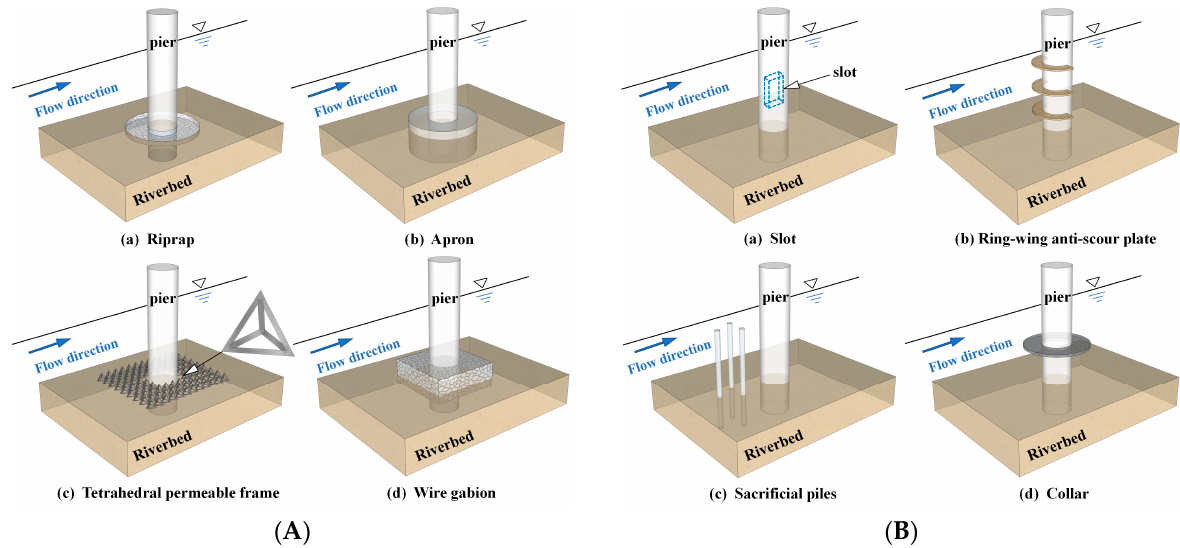
Figure 1. Scour reduction measures. ( A ) Passive measures. ( B ) Active measures.